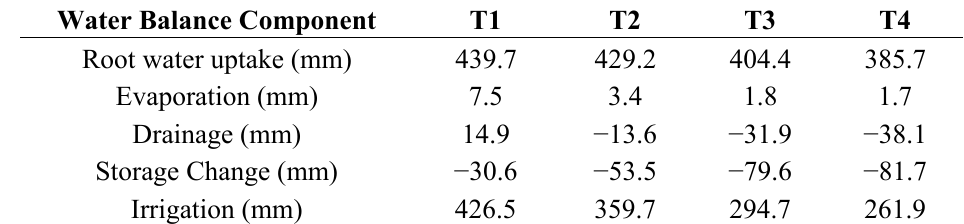
Table 5. Simulated water balance components of each treatment from 19 June to 17 September